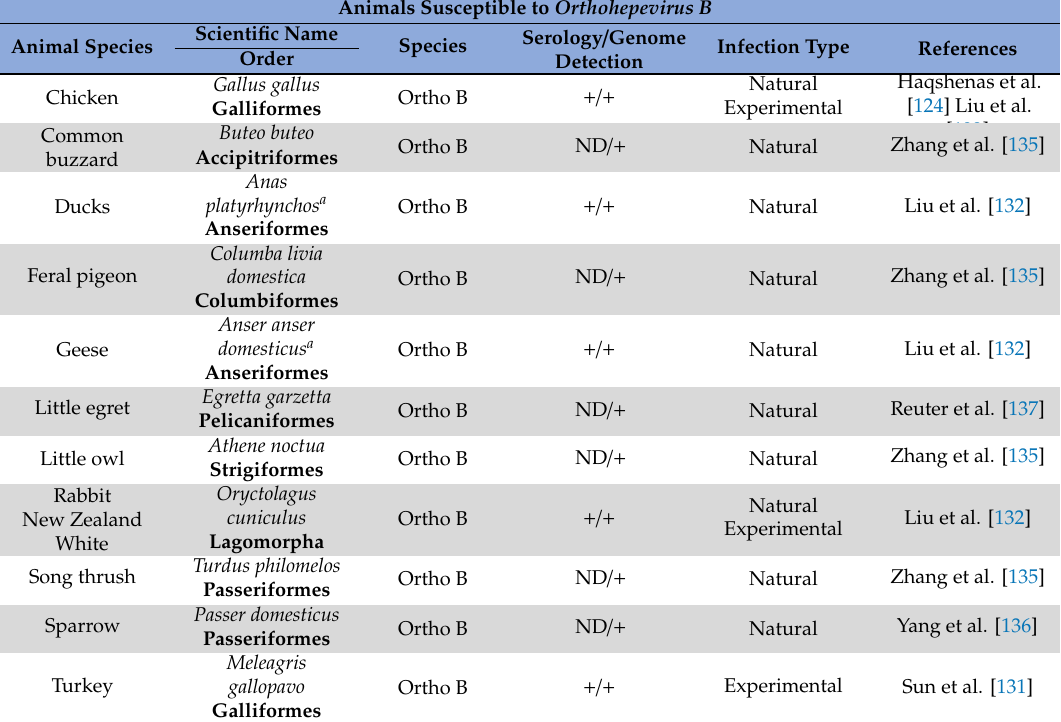
Table 2 Animals associated with Orthohepevirus B infection. Names in bold represent taxonomic order. Under serology / genome detection “ + ” indicates any positive report for that assay within the literature, “-“ represents